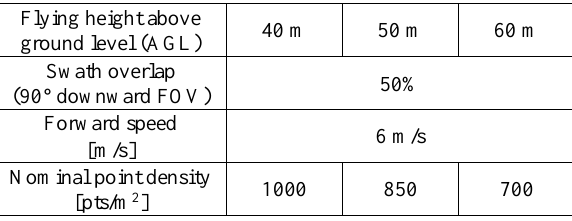
Table 1. UAS lidar flight